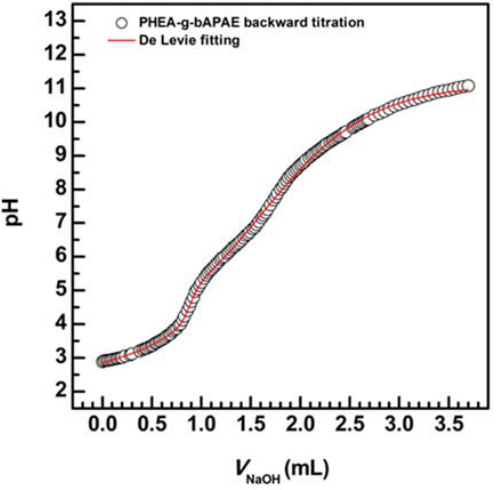
Figure 4. Backward acid–base titration (NaOH volume versus pH) of PHEA ‐ g ‐ bAPAE and De Levie fitting curve.